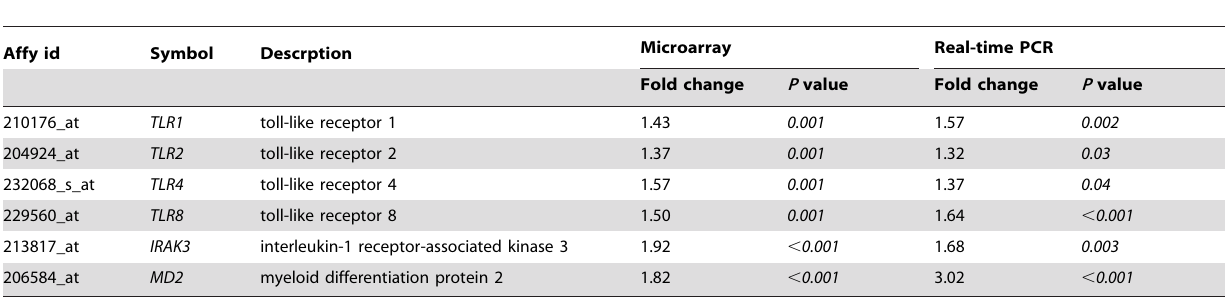
Table 4. Quantitative real-time PCR validation of TLR pathways related gene expression